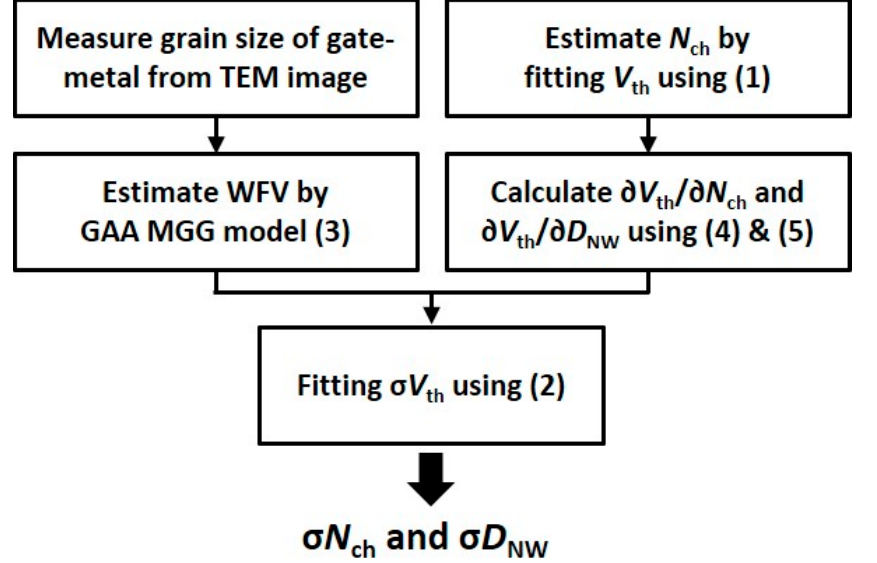
Figure 4. Flowchart of the proposed σ V th modeling